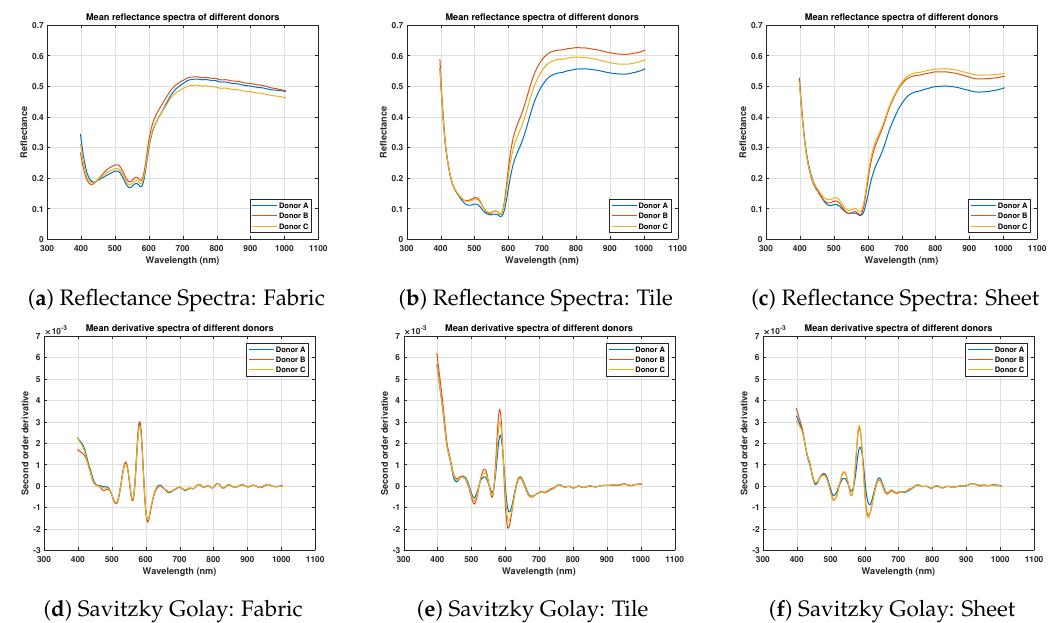
Figure 4. Mean reflectance spectra of different blood donor samples and Savitzky Golay second-order derivative spectra comparison over White Fabric, Whtile Tile, and Wall Sheet.